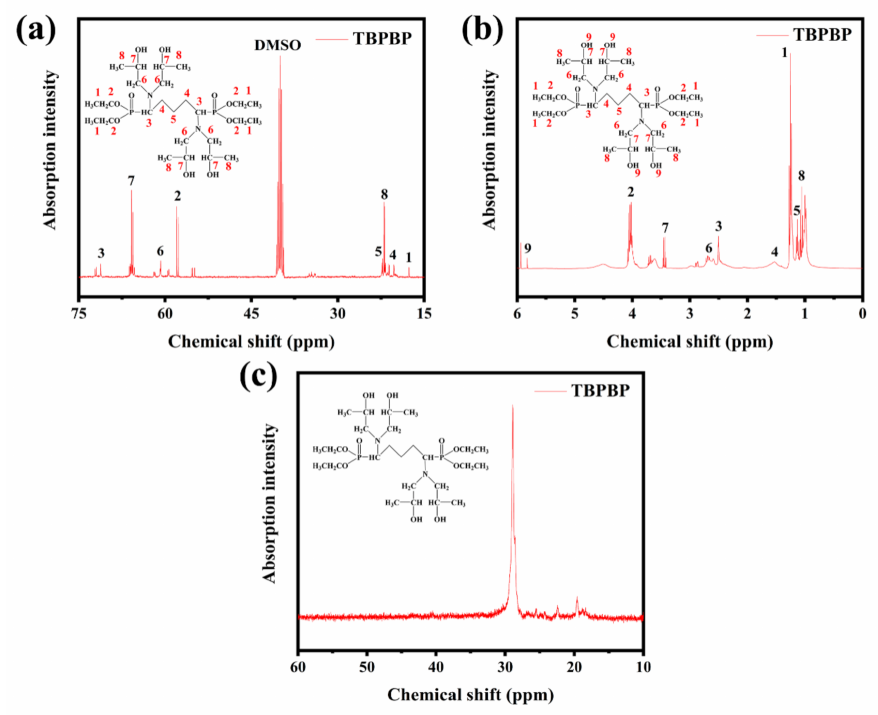
Figure 3. NMR spectra of TBPBP: 13 C NMR ( a ), 1 H NMR ( b ), 31 P NMR ( c